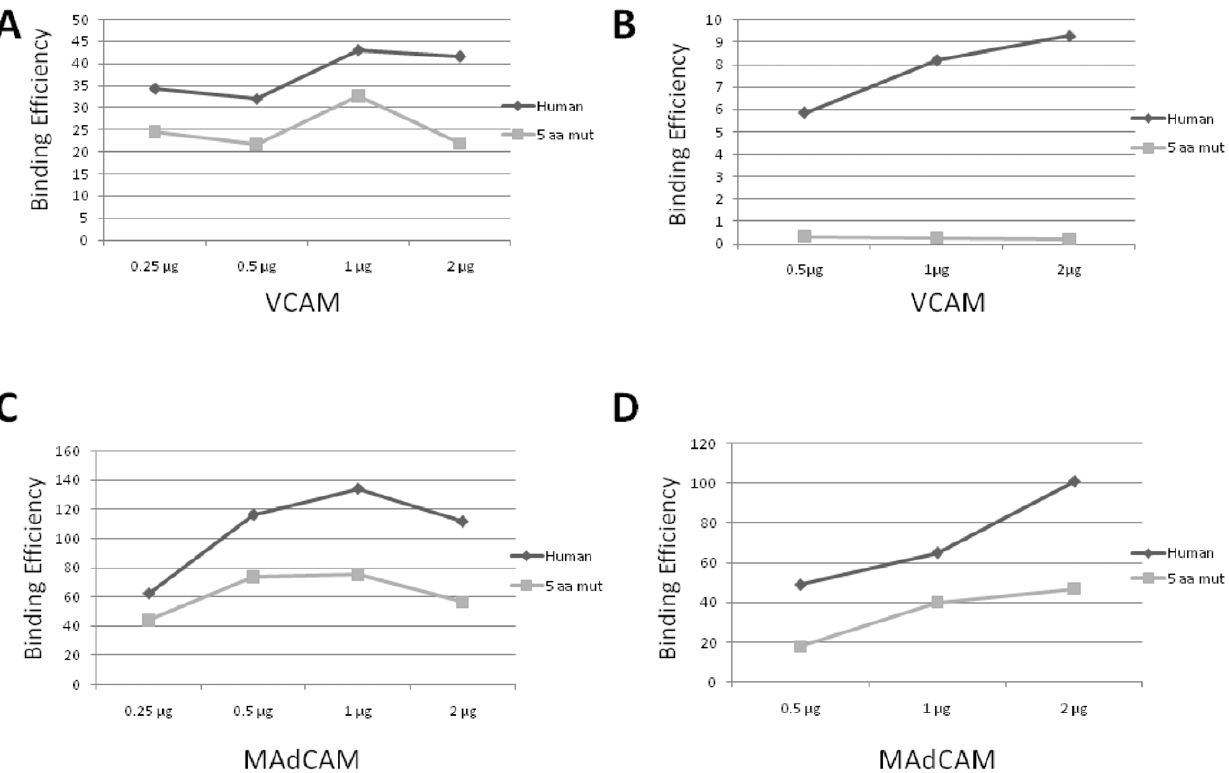
Figure 4. Binding efficiencies (BE) of VCAM ( A and B ) and MAdCAM ( C and D ) to the human a 4 and the quintuple a 4 mutant (5 aa mut) in the presence of Mn 2 + ( A and C ) and Mg 2 + ( B and D ). Ligands were tested at different amounts (0.25 to 2 m g).